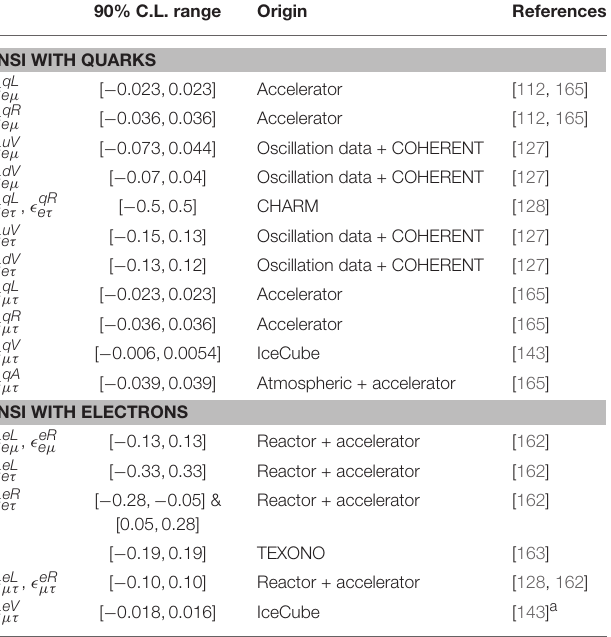
TABLE 3 | Bounds on flavor changing NC NSI couplings.